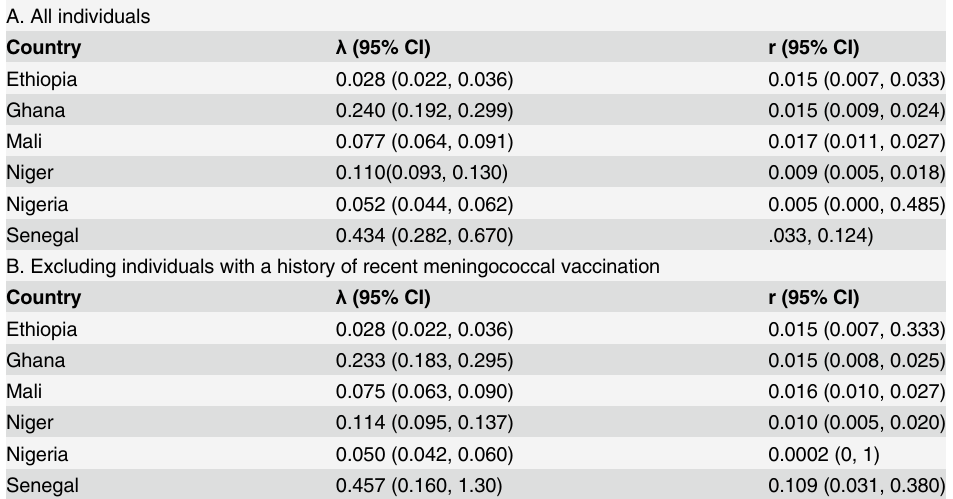
Table 5. Estimates of the annual force of infection ( λ ) and seroreversion (r) by